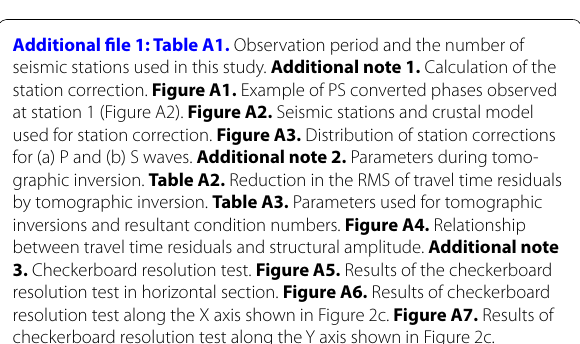
Figure A1. Example of PS converted phases observed at station 1 (Figure A2). Figure A2. Seismic stations and crustal model used for station correction. Figure A3. Distribution of station corrections for (a) P and (b) S waves. Additional note 2. Parameters during tomo- graphic inversion. Table A2. Reduction in the RMS of travel time residuals by tomographic inversion. Table A3. Parameters used for tomographic inversions and resultant condition numbers. Figure A4. Relationship between travel time residuals and structural amplitude. Additional note 3. Checkerboard resolution test. Figure A5. Results of the checkerboard resolution test in horizontal section. Figure A6. Results of checkerboard resolution test along the X axis shown in Figure 2c. Figure A7. Results of checkerboard resolution test along the Y axis shown in Figure